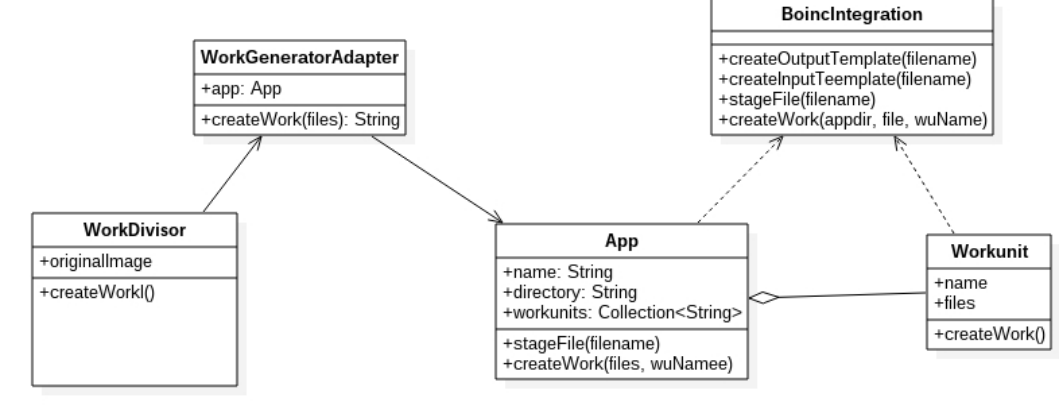
Figure 3: Class Diagram of the Work Generator